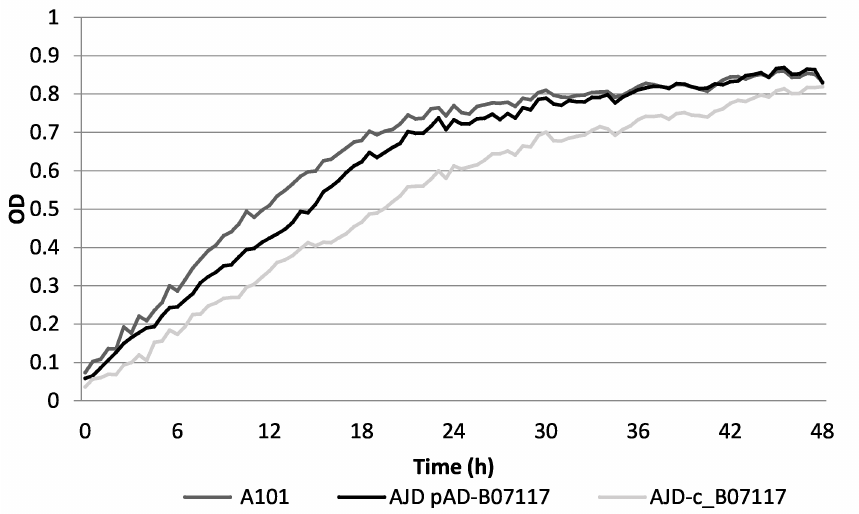
Figure 4. Bioscreen analysis of the strains created in this study on YNB media with 5% ( w / v ) glycerol. The A101 strain (gray) was used as a control. AJD pAD-B07117 (black) showed a similar growth to the control whereas AJD-c-B07117 (light grey) displayed an initially impaired growth. All of the strains reached a similar OD value by the end of the 48 h